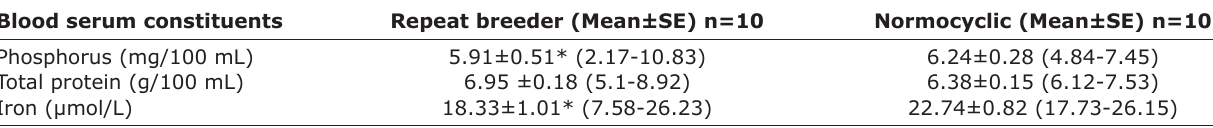
Table-5: Systemic iron, phosphorus, and total protein level in normocyclic and repeat breeder cows. Blood serum